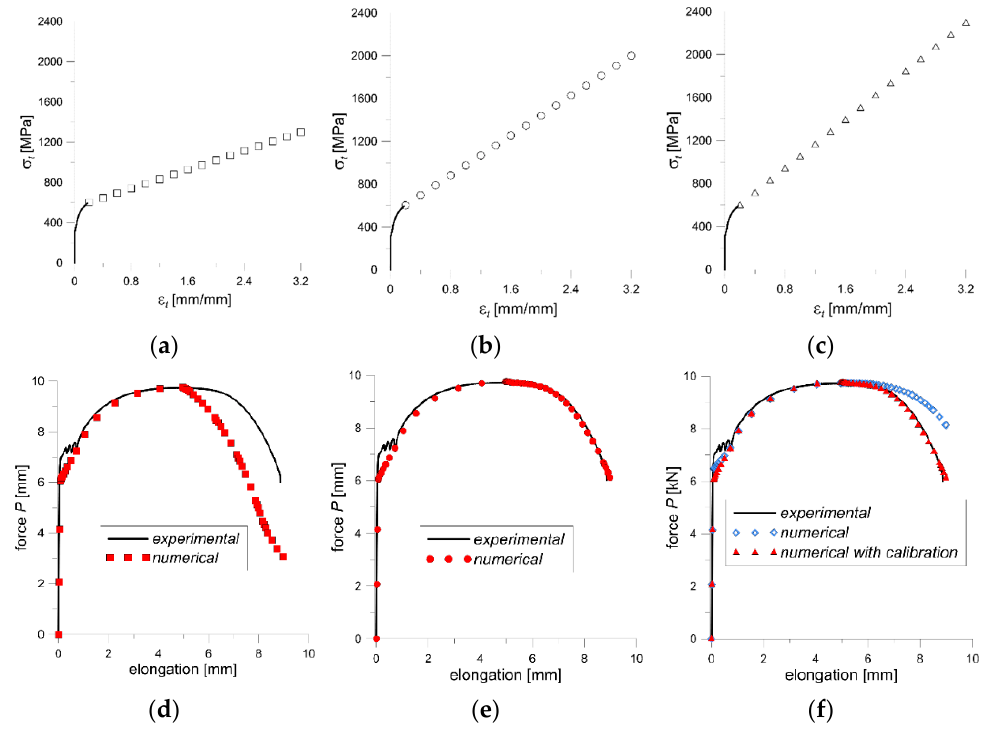
Figure 12. The stress-strain graphs for: ( a ) var. 1, ( b ) var. 2, ( c ) var. 3, and suitable numerical and experimental force-elongation curves for: ( d ) var. 1, ( e ) var. 2, and ( f ) var. 3.